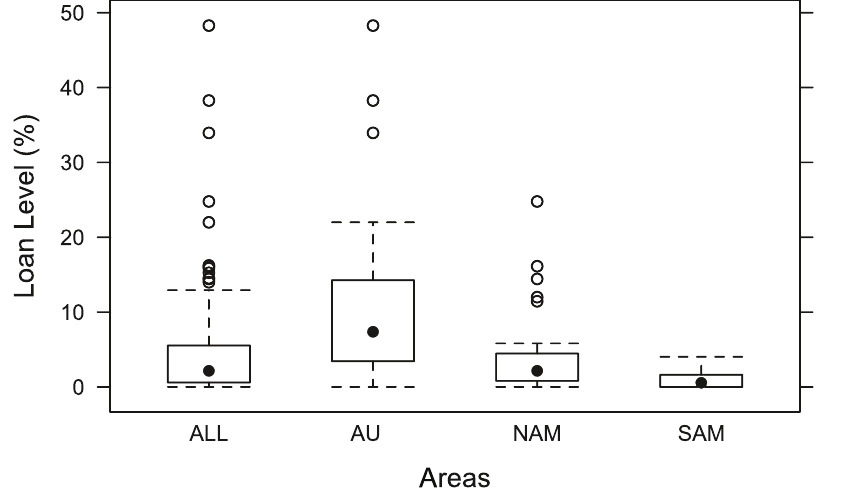
Figure 1. Loan figures aggregated and by region. Box-and-whiskers plot of loan levels aggregated for all regions (ALL) individually for the case study areas (AUS=Australia; NAM=California and the Great Basin area of North America; SAM=Amazonian region of South America).